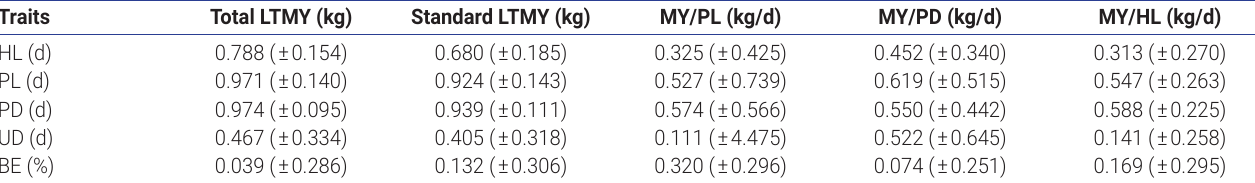
Table 4. Genetic correlation among lifetime traits